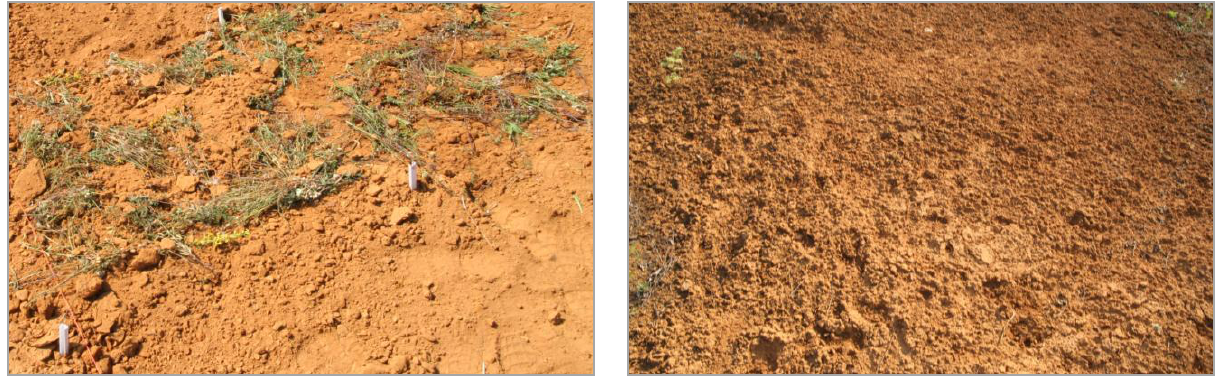
Fig. 8. Comparison of turf transplanted plots in 2009 and 2013 ( A. Rostański )